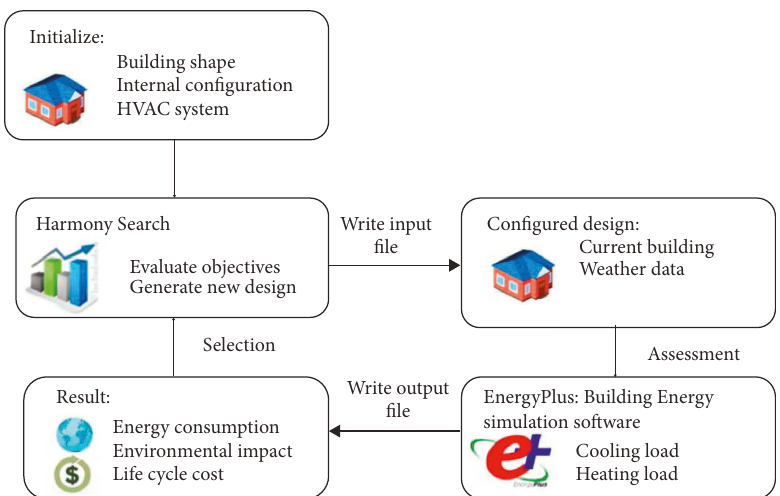
Figure 9: Illustration of schematic structure of the life cycle analysis